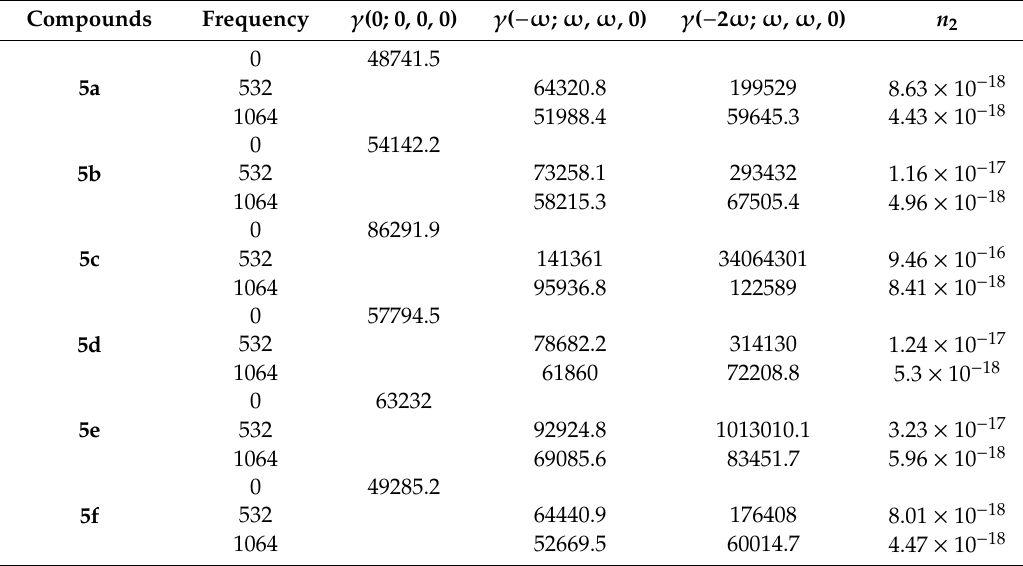
Table 6. The static, dc-Kerr e ff ect, electric field-induced second harmonic generation coe ffi cients (in au), and quadratic non-linear refractive index ( n 2 = cm 2 / W) at di ff erent wavelengths (in nm) for compounds ( 5a – f